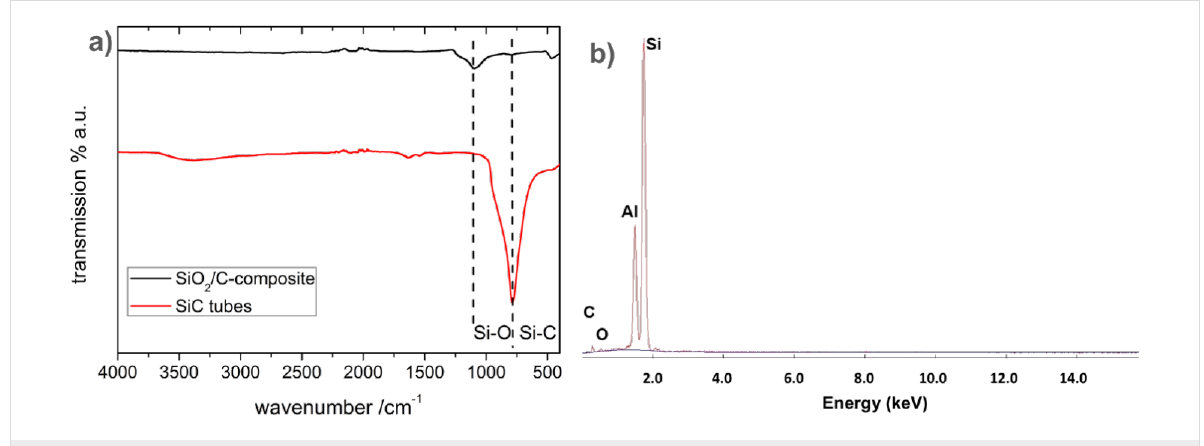
Figure 8: (a) IR spectra of the silica@carbon composite ( 3 ) (black/top) and the silicon carbide tubes ( 5 ) (red/bottom). (b) EDX spectra of the SiC tubes ( 5 ) revealing 29.6 wt % C; 5.22 wt % O; 65.2 wt % Si; 46.7 atom % C; 6.42 atom % O; 46.0 atom % Si.